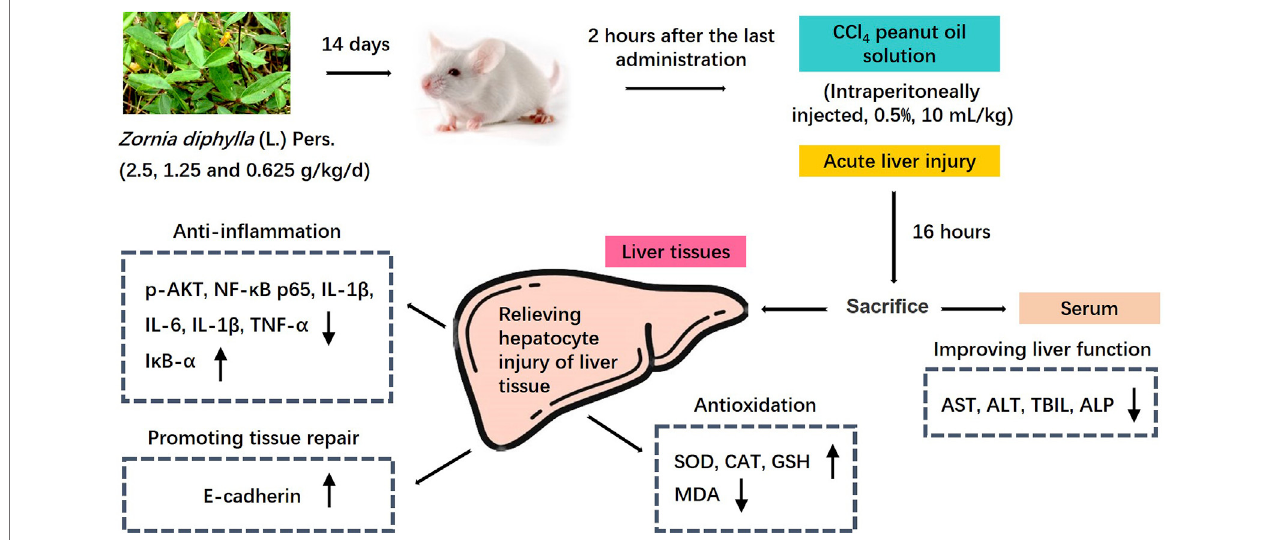
FIGURE 9 | Mechanism diagram of the protective effects of ZDP on the murine model of ALI induced by CCl 4 .